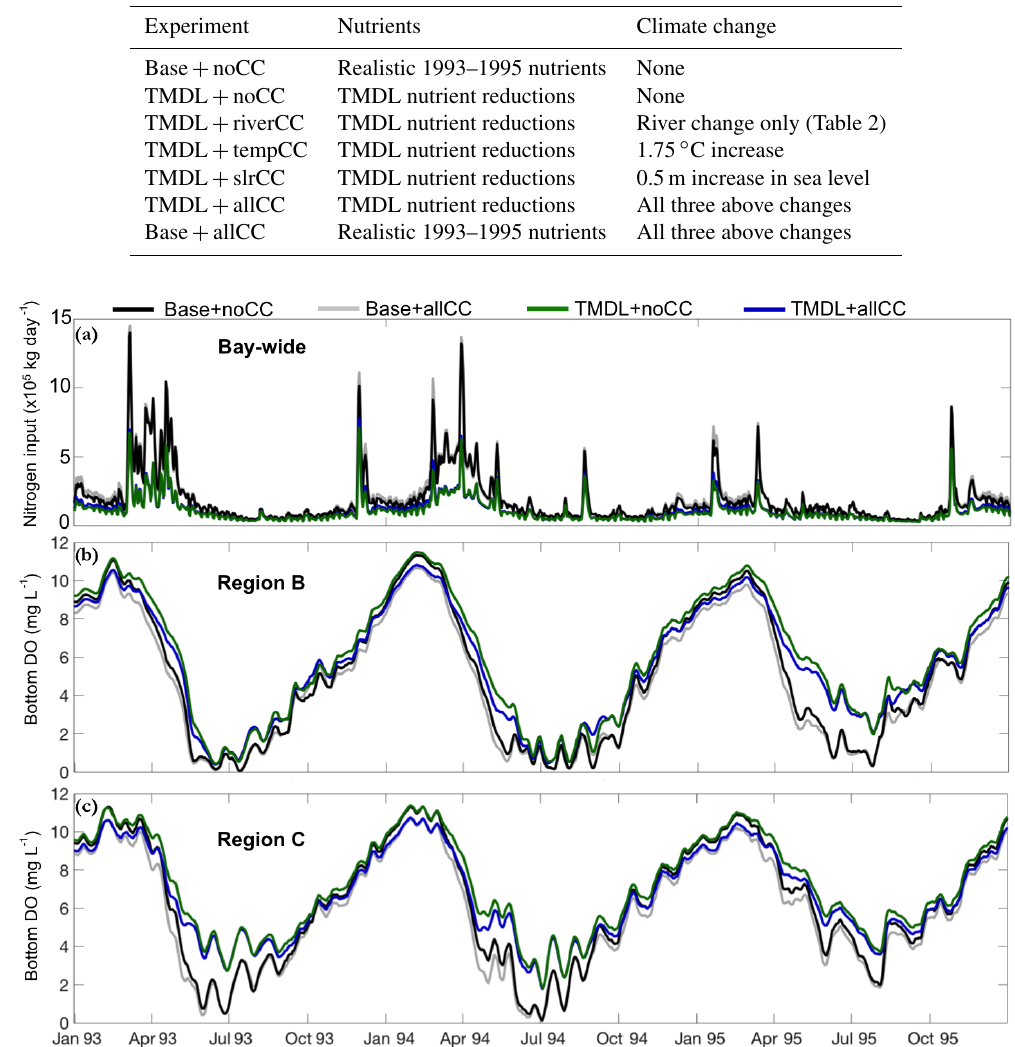
Figure 2. (a) Total (bay-wide) riverine nitrogen loading into the bay, (b) time series (7-day running mean) of bottom DO with and without nutrient reductions (TMDL vs. Base) and with and without climate change (allCC vs. noCC) for the average of the stations in the upper mesohaline Region B, and (c) as in (b) but for the lower mesohaline Region